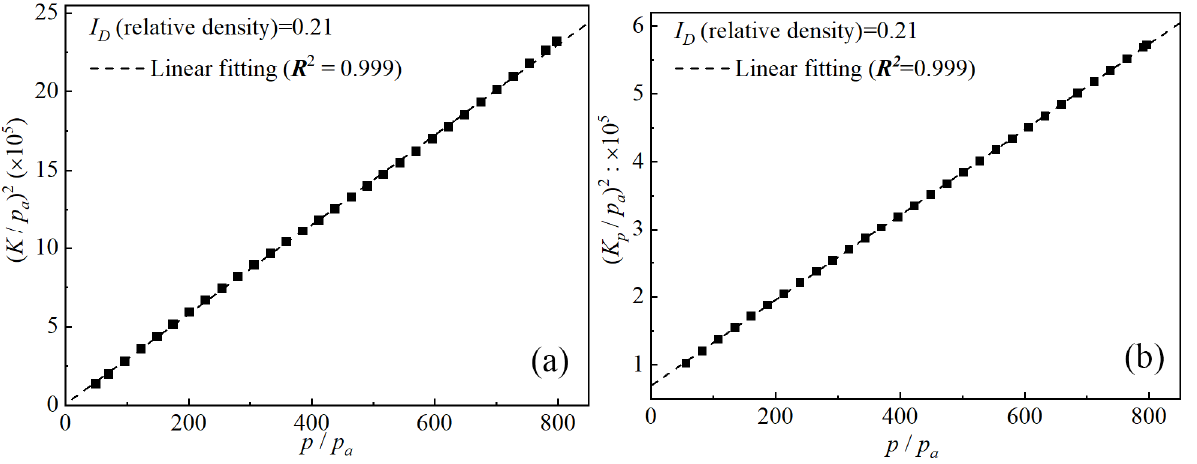
Table 2. Parameters for empirical formulations in CICT.